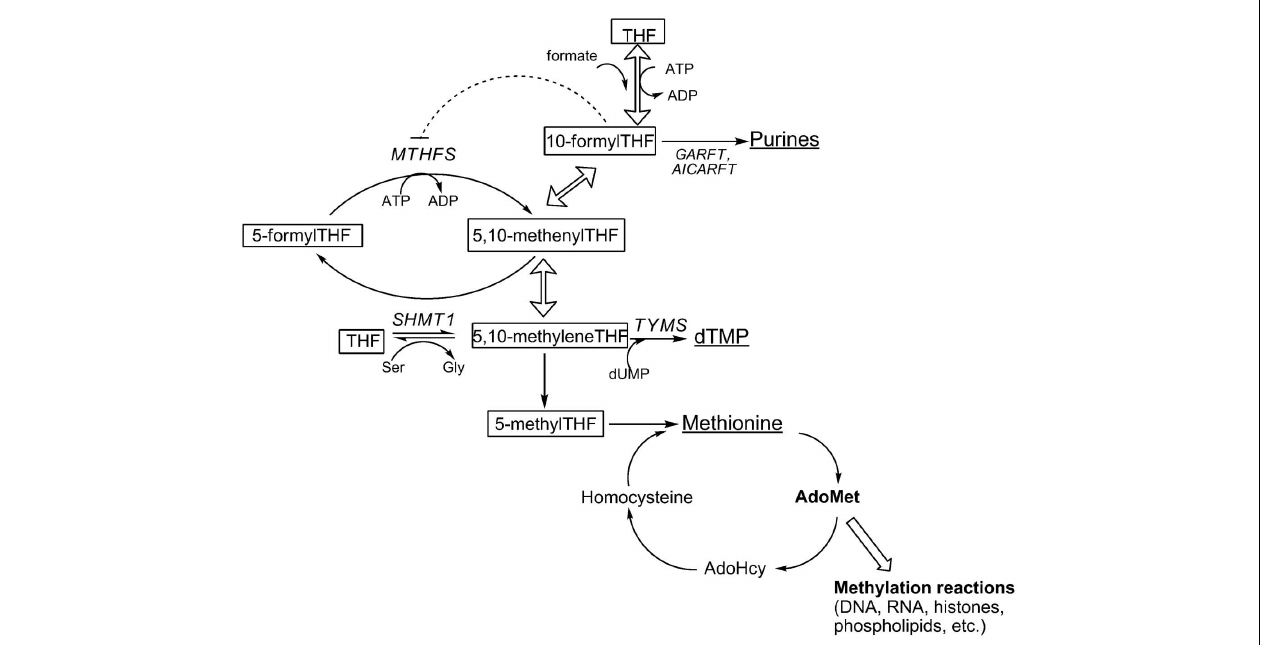
FIGURE 1 | Folate-dependent one-carbon metabolism in the cytoplasm. Products of one-carbon metabolism are underlined; folate cofactors are boxed.THF, tetrahydrofolate; MTHFS, methenyltetrahydrofolate synthetase; SHMT1, serine hydroxymethyltransferase; GARFT, glycinamide 10-formyltetrahydrofolate synthetase activity of the